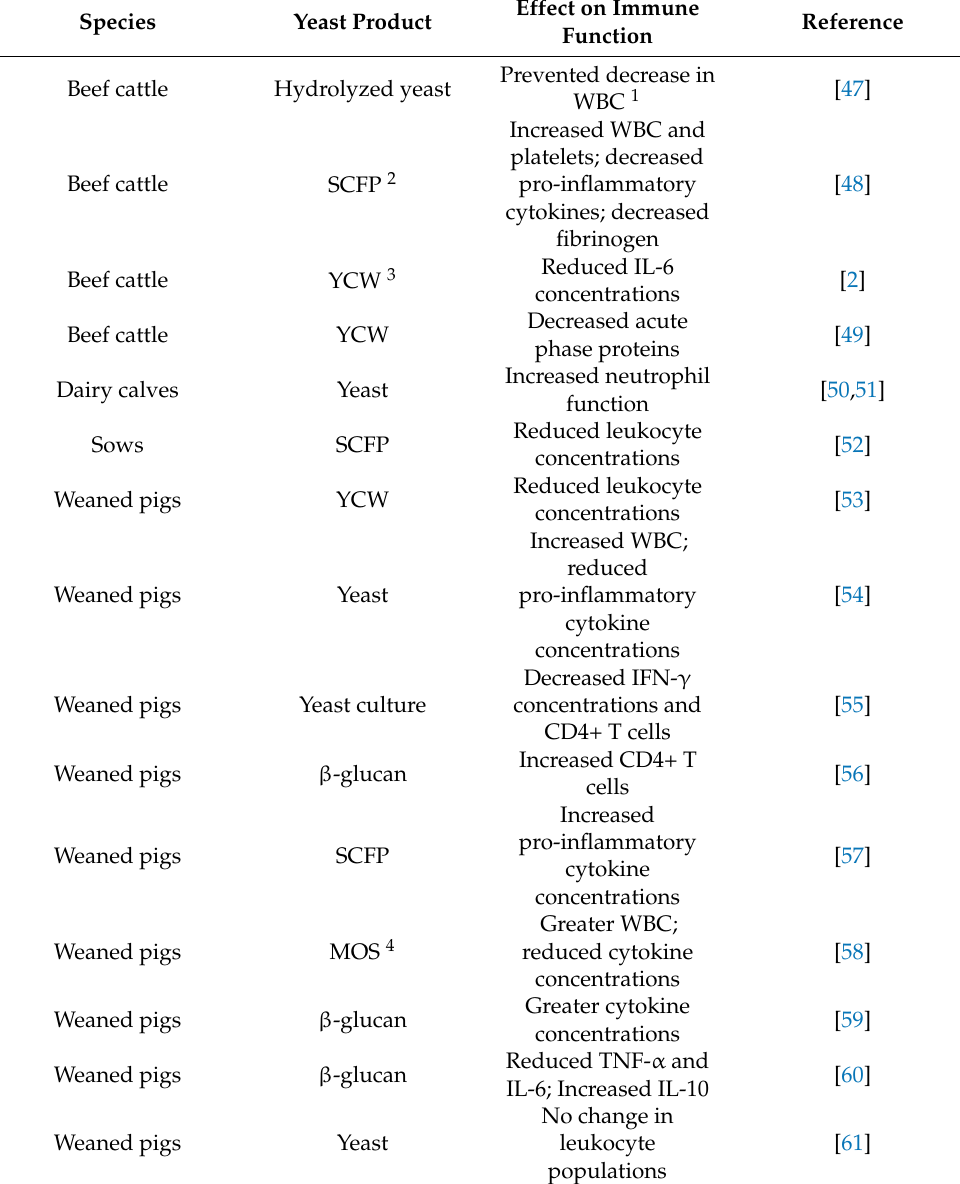
Table 1. Effects of yeast and yeast-based product supplementation on the immune response in cattle and